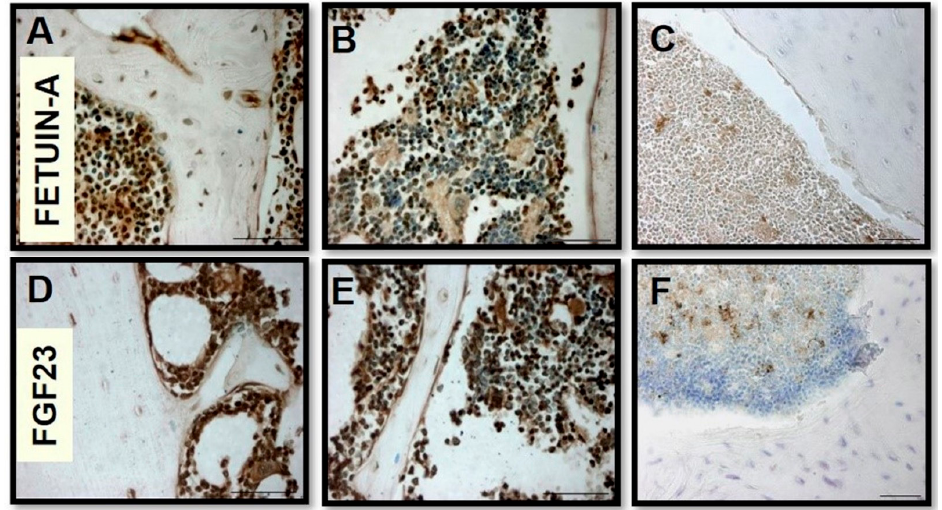
Figure 1. Immunostaining of Fetuin-A ( A , B ) and Fibroblast growth factor 23 (FGF23) ( D , E ) in mice bone marrow tissues. Negative control, respectively, ( C ) and ( F ). Scale bar = 50 μ m.